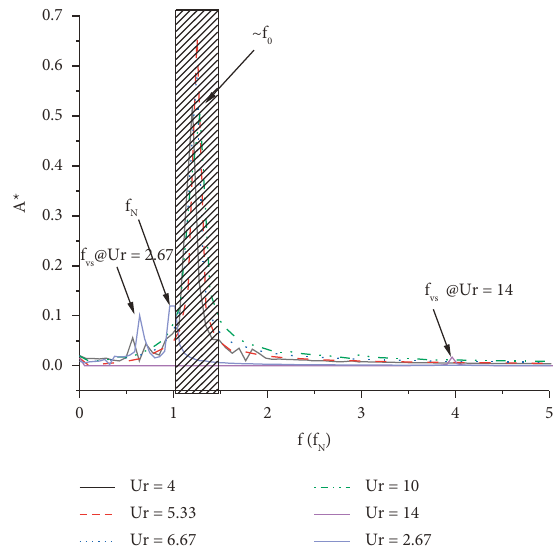
Figure 6: Displacement spectra of the cylinder